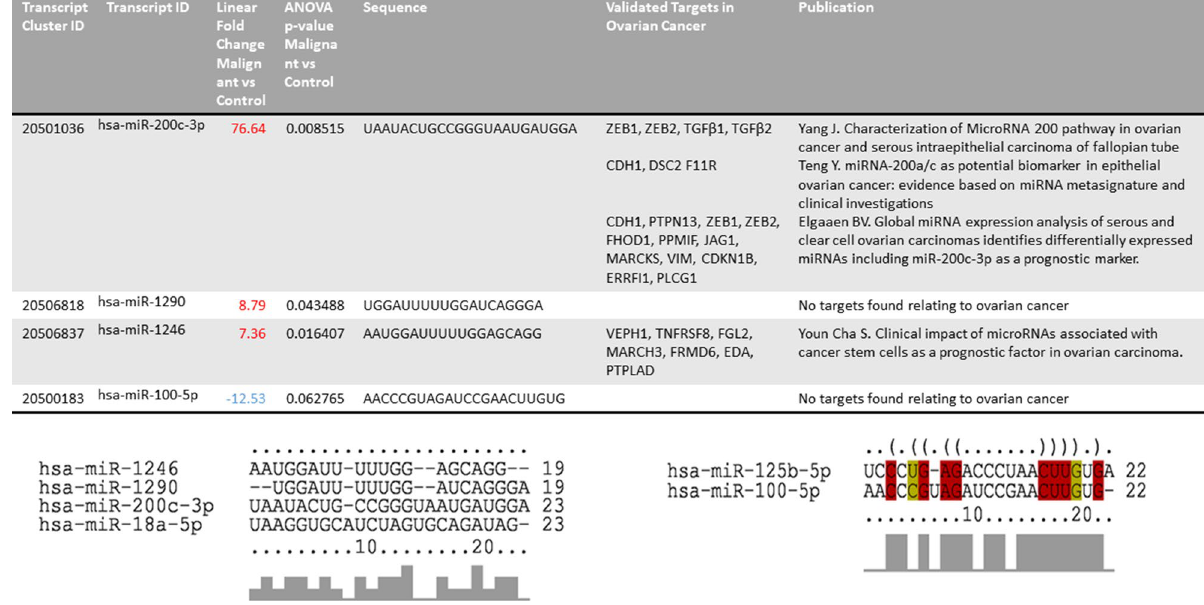
Table 1. Micro-RNAs and their predicted targets in Extracellular vesicles isolated from ascitic supernatant.